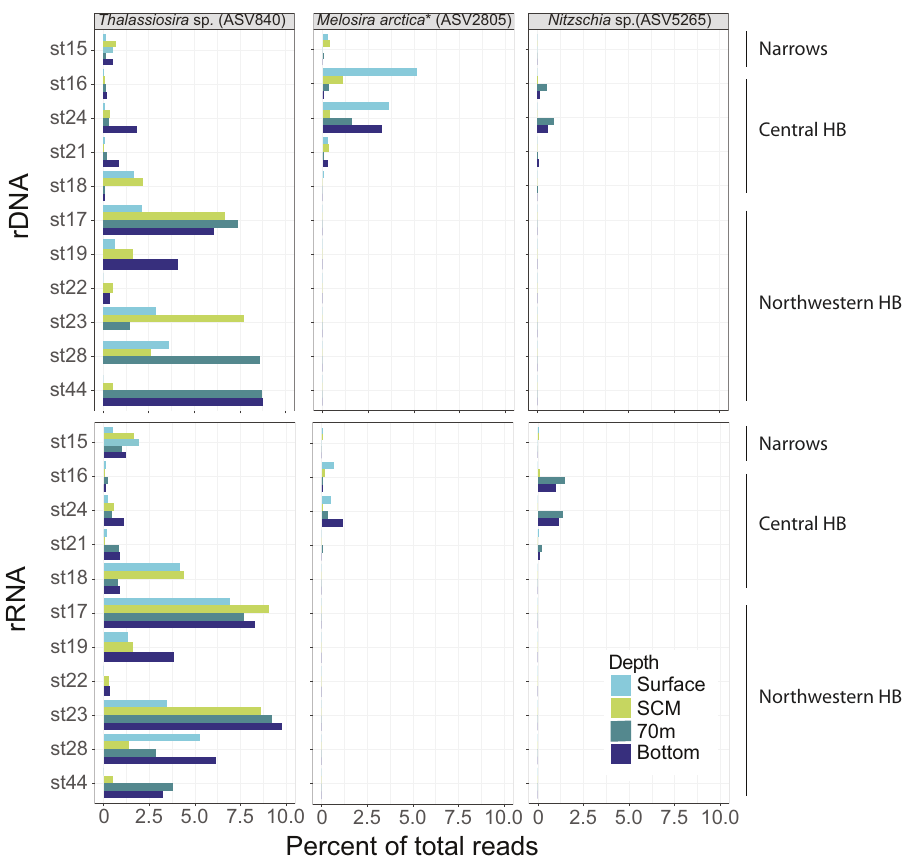
Fig. 6 Distribution of key diatom ASVs. Thalassiosira sp., Melosira arctica and Nitzschia sp . down the water column from the rDNA (upper panels) and rRNA (lower